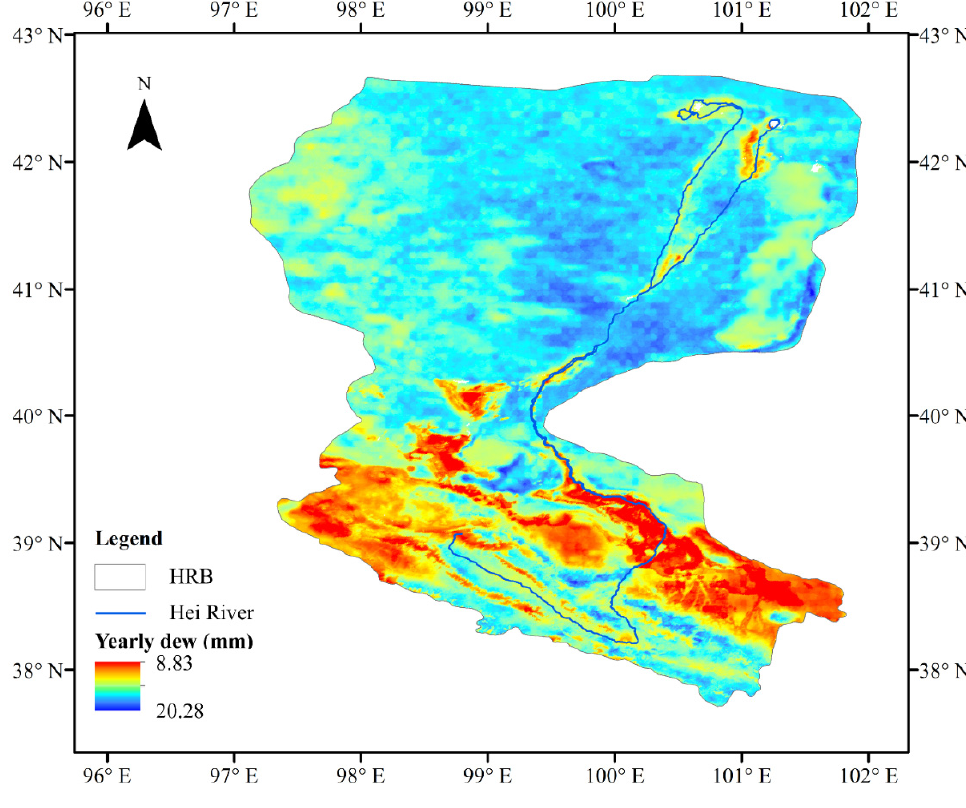
Figure 10. Basin-scale average amounts of dew per month for 2013–2017 estimated using the SVM model.